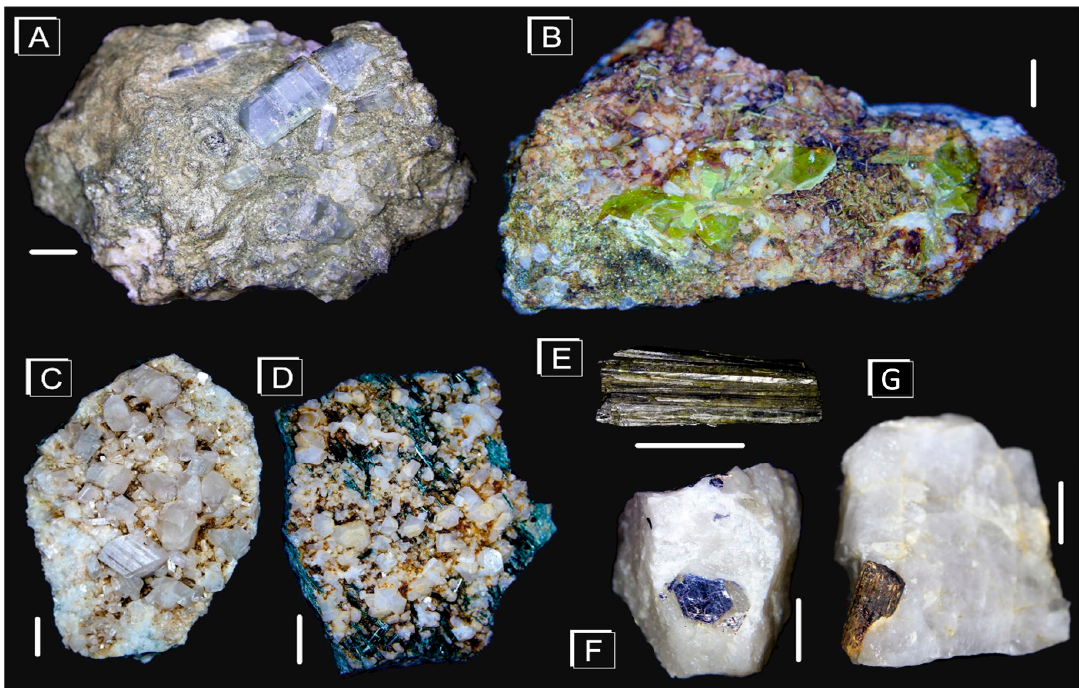
Figure 2. Example of minerals within the investigated veins. ( A ) Blue apatite crystal on albite and chlorite, ( B ) green titanite, ( C ) albite crystals, ( D ) actinolite overgrown by albite, ( E ) epidote aggregate, ( F ) molybdenite flake on milky quartz, and ( G ) rutile crystals in quartz. Scale bars are 1 cm.